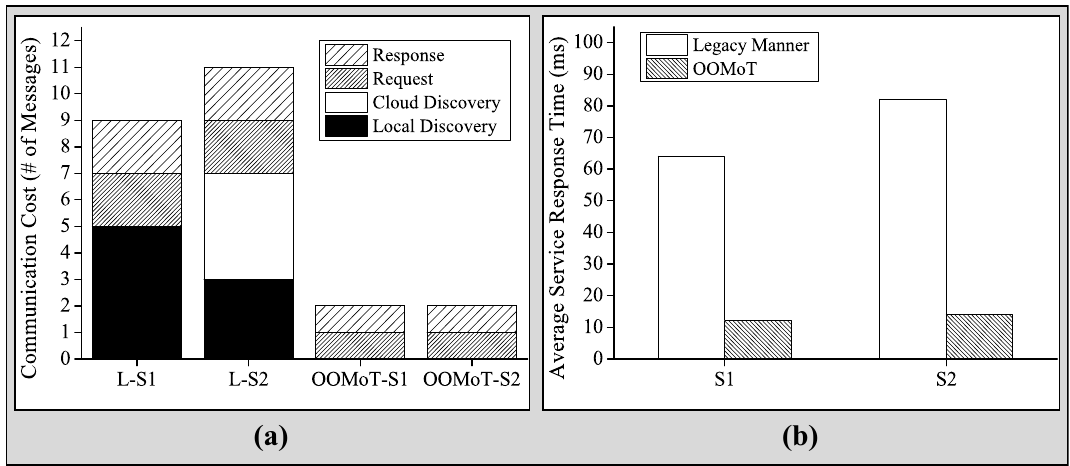
Figure 8. Experimental results of legacy method and OOMoT for two service scenarios S 1 and S 2 (L-S1, L-S2, OOMoT-S1, and OOMoT-S2): ( a ) communication cost ( b ) control